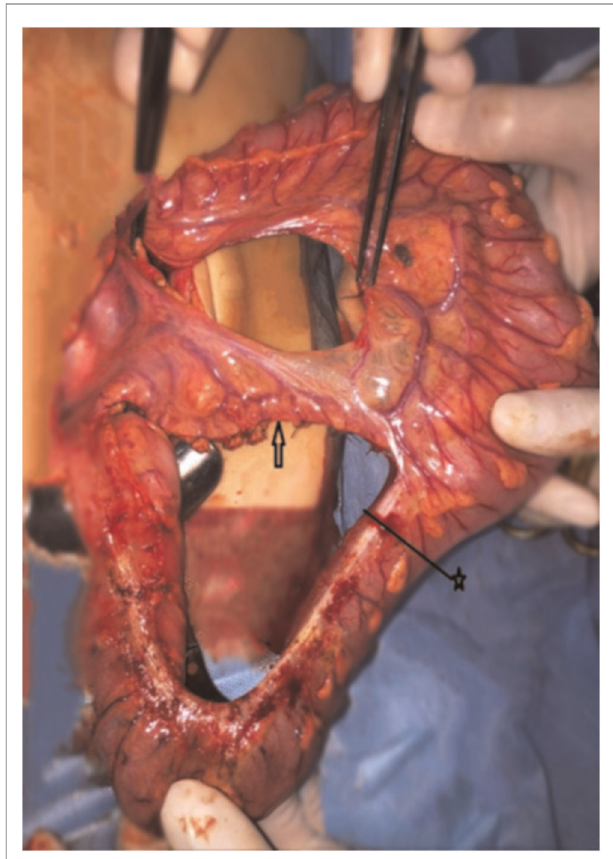
FIGURE 2 | The arrow indicates the preserved sigmoid arteries. The tweezers indicate ligated left colic artery. The distance between the ends of the tweezers indicates how much bowel is free. ★ — border of the colon resection.